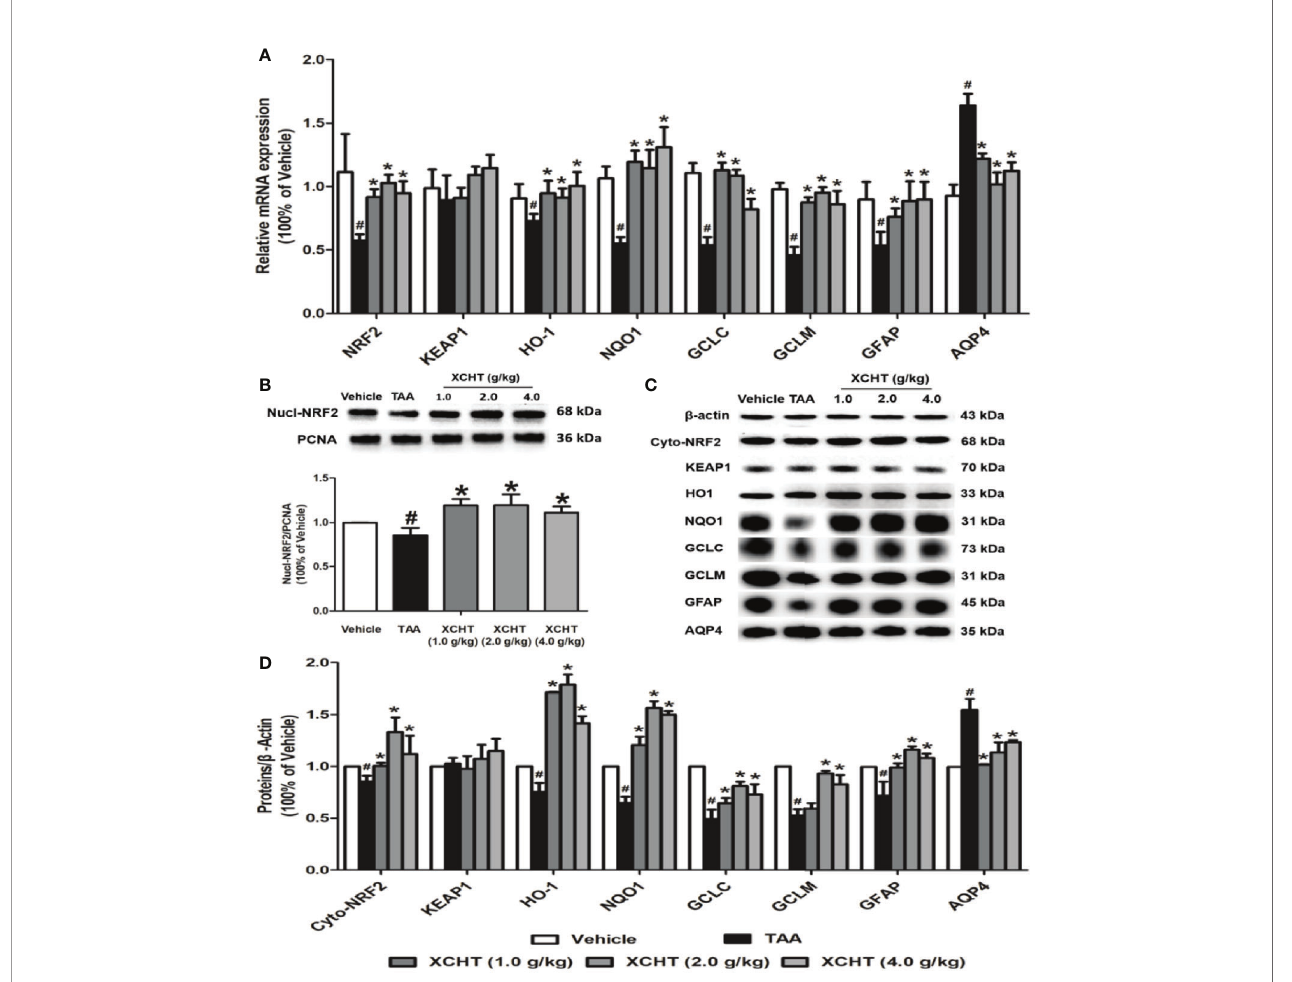
FIGURE 5 | Effect of XCHT on TAA-induced AHE in rats by activating cortical astrocytes NRF2 pathway. (A) The mRNA expression of NRF2, KEAP-1, HO-1, NQO- 1, GCLC, GCLM, GFAP and AQP4. (B) The protein expression of Nucl-NRF2. (C, D) The protein expression of Cyto-NRF2, KEAP-1, HO-1, NQO-1, GCLC, GCLM, GFAP and AQP4. Data were expressed as mean ± SD (n = 5-7). # p < 0.05, *p < 0.01 vs. the TAA